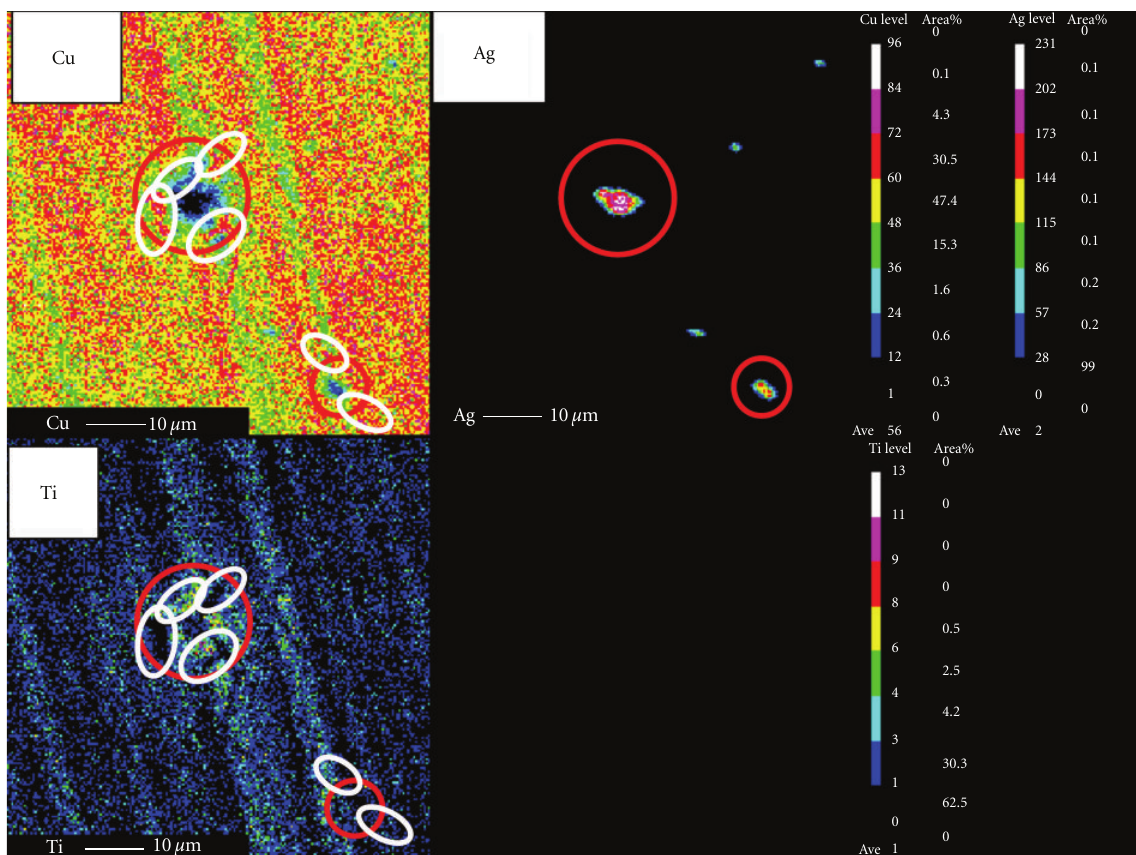
Figure 9: EPMA image of Ag-doped TiO 2 film prepared under the condition of R = 50wt%.